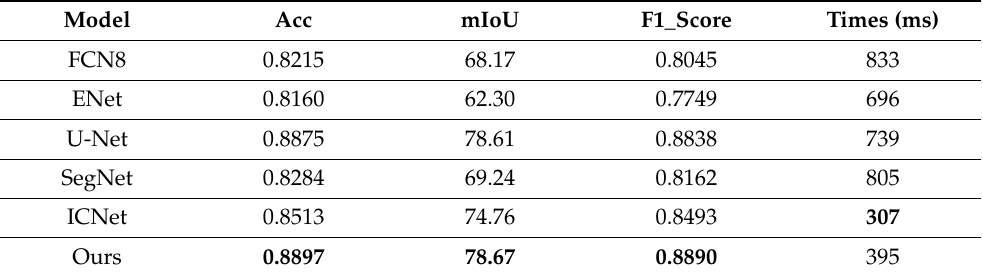
Table 2. Comparison of various segmentation indices of different algorithms.